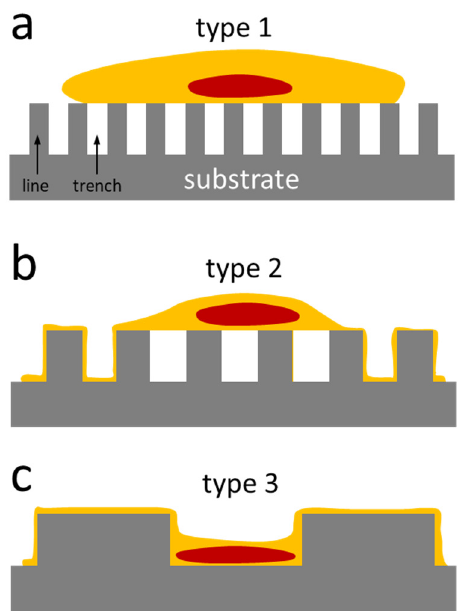
Figure 7. Schematic drawings of three different types of cell cross-sectional morphology observed with increasing line and trench widths. ( a ) Cell “floated” on top of the comb structure; ( b ) pseudopodia located at the edge of cells descended into the trenches; ( c ) entire cell including the nucleus formed a conformal coating on the comb structure surface.